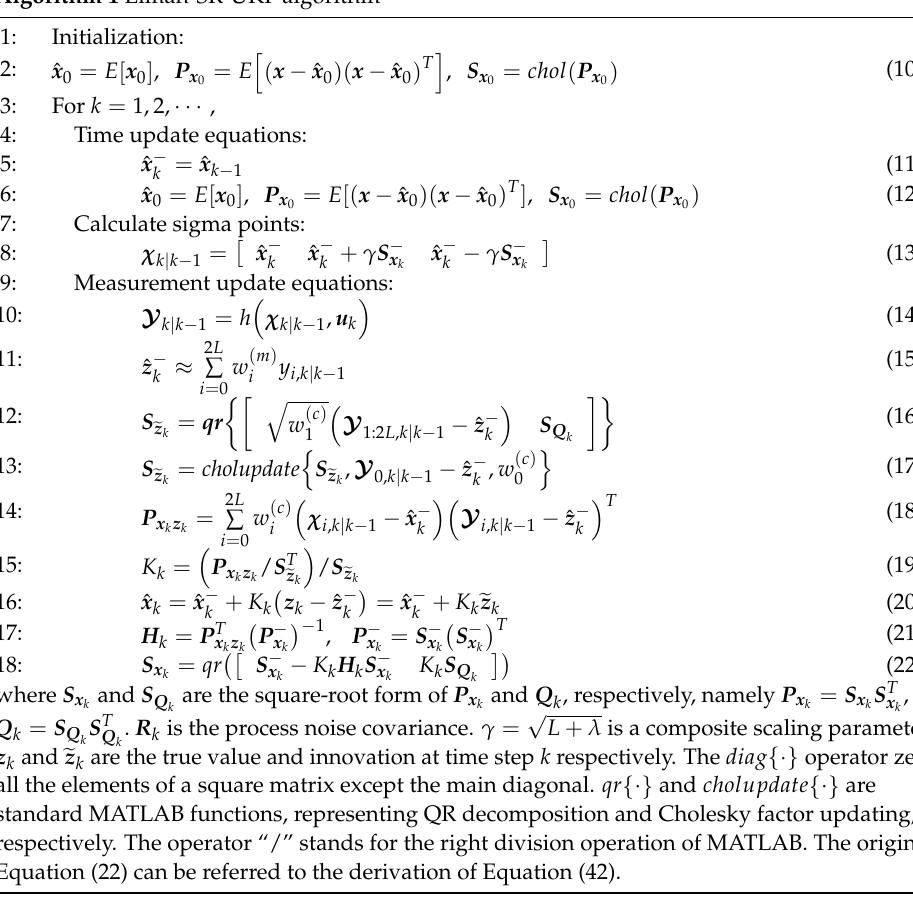
Algorithm 1 Elman-SR-UKF